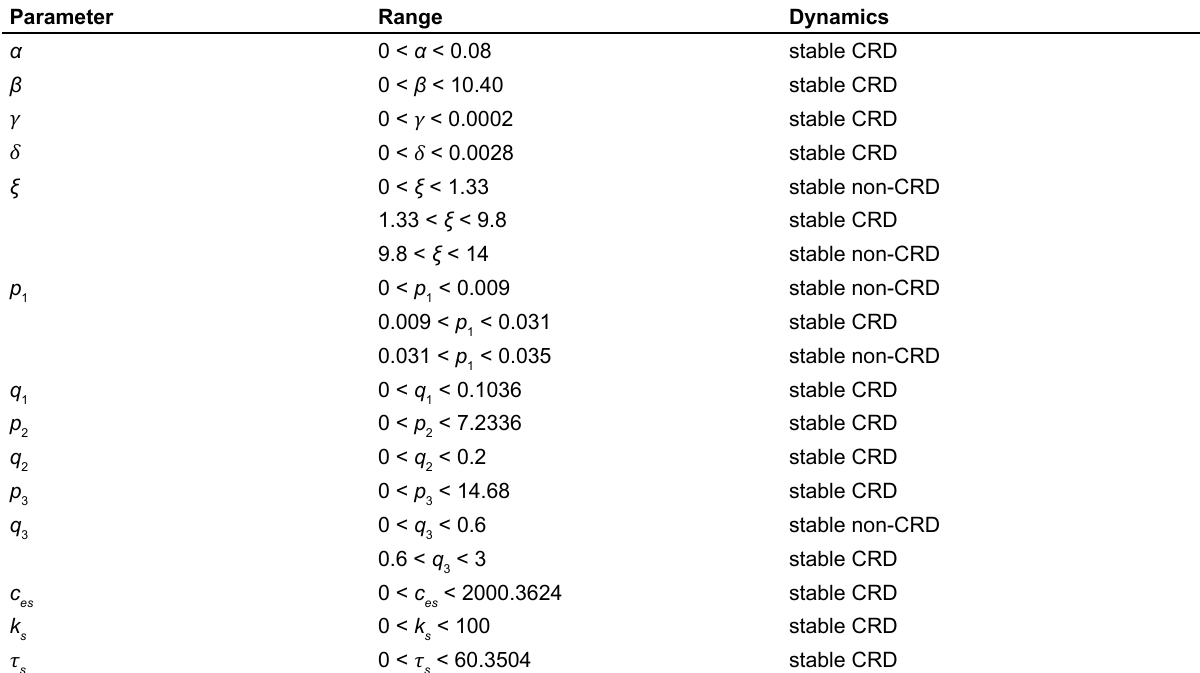
Table 3. Robustness analysis table: effect of individual parameter variation on dynamics of the whole system. Here CRD and non-CRD indicate control response dynamics and non-control response dynamics respectively. By varying each parameter value individually, we observed and recorded the ranges for CRD model dynamics and non-CRD model dynamics Parameter